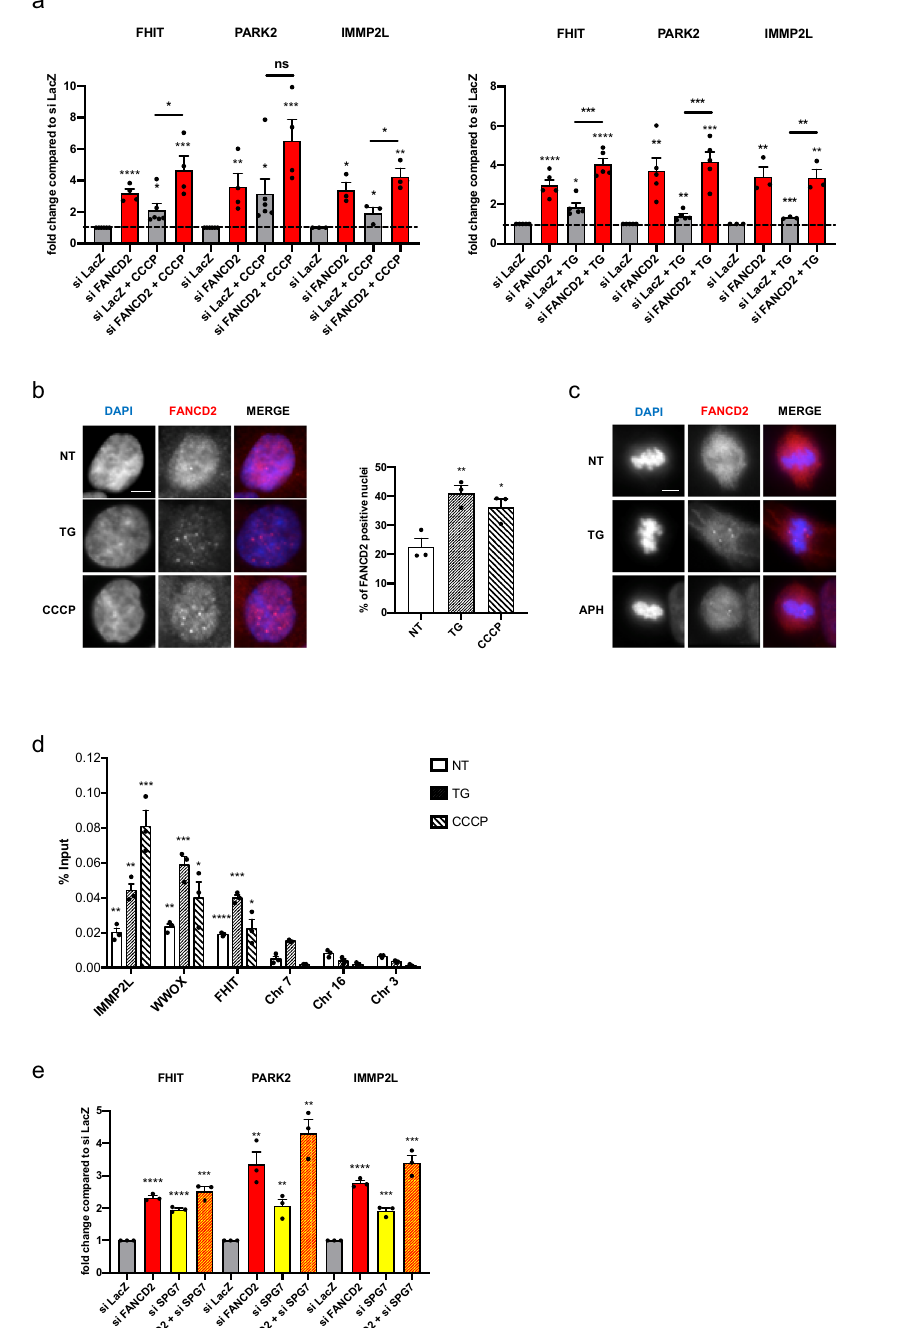
of mitochondrial stress signaling reduces chromosome fragility in the absence of a functional FANC pathway.